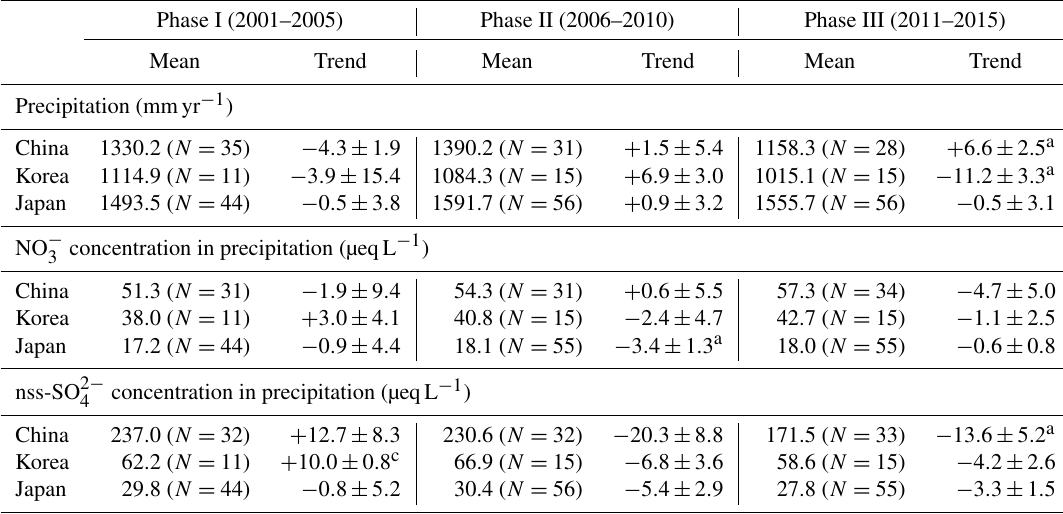
concentration in precipitation, and nss-SO 2 − 3